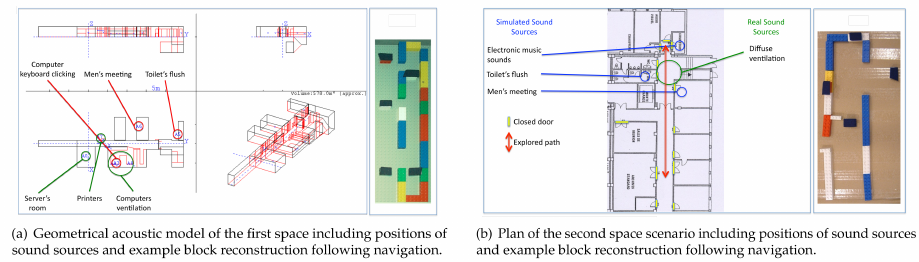
Figure 3. Virtual reality scenarios of the architectural test spaces and example block reconstructions for the architectural perception study